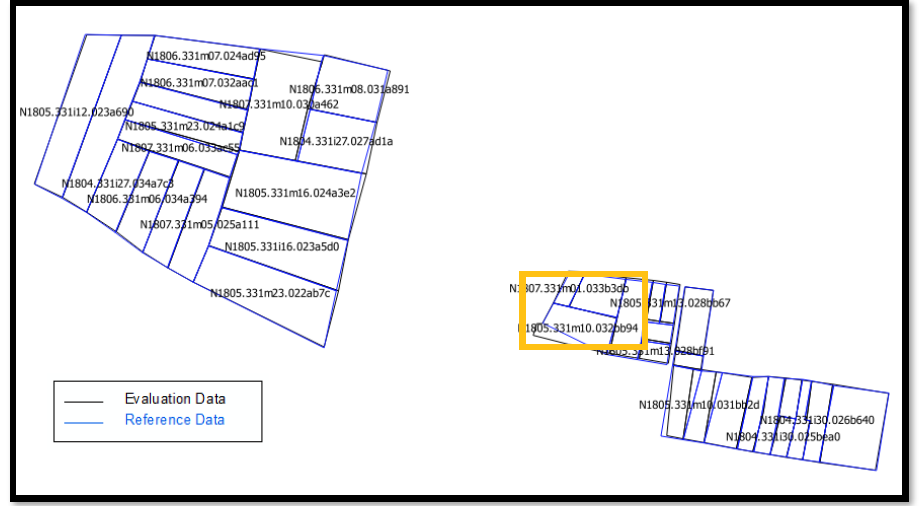
Figure A4. Visualization of land parcels used as evaluation and reference data in Grobogan using AutoCAD.